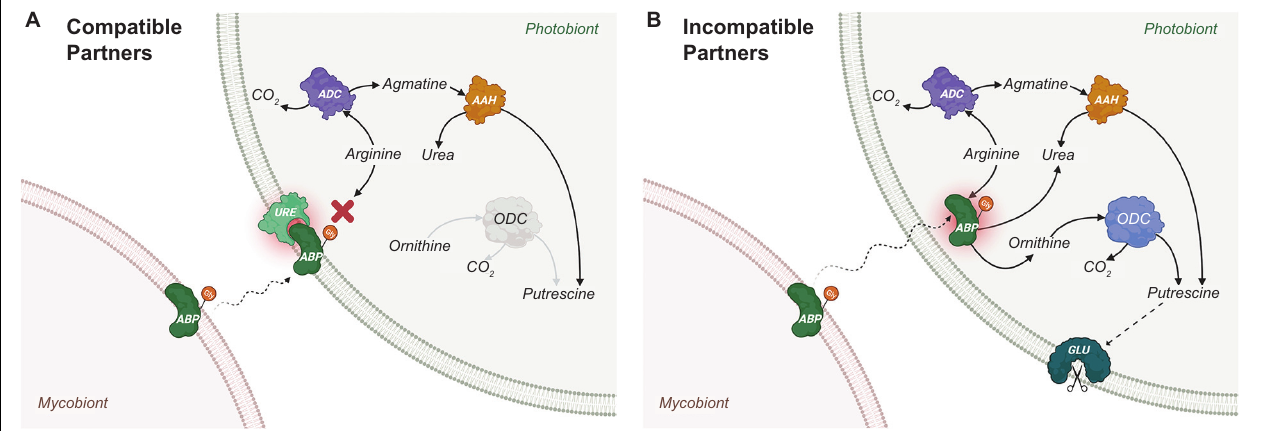
FIGURE 2 | Proposed lectin-ligand recognition and signalling for Xanthoria parietina. (A) For compatible partners. The process starts by the production and positioning of algal binding protein (ABP) on the cell wall of the mycobiont. ABP is a lectin (“receptor”) which is glycosylated and secreted into the intercellular space (Molina et al., 1993; Molina and Vicente, 1995) to bind specific cognate ligands of a photobiont, with which a potential lichenisation could be established. It is speculated that ABP is part of a group of “recognition lectins” that is responsible for engaging the mycobiont with a specific photobiont, and another group of “recruitment lectins” that play a role in recruiting the photobiont cells to mycobiont hyphae (Sacristán et al., 2007). In the lichen X. parietina , a recruitment lectin was identified as a secreted arginase of the Xanthoria mycobiont (SAX). Although both ABP (recognition) and SAX (recruitment) mycobiont lectins were shown to bind to the ligand URE, a glycosylated urease located on the compatible photobiont cell wall (Millanes et al., 2004), it is not clear whether both must attach to urease for lichenisation to proceed. Both ABP and SAX lectins possess identical peptide sequences and Mn 2 + -dependent arginase activity, hydrolysing arginine to produce urea and ornithine (Legaz et al., 2004). However, the glycosidic moiety of SAX contains galactose and glucose, whereas that of ABP contains glucose and N-acetyl-glucosamine (Molina et al., 1993). Upon binding, enzymatic activities of ABP (recognition lectin and receptor) and URE (ligand) are inhibited. As a result, putrescine concentrations in a compatible photobiont are kept at relatively low endogenous levels because it is only produced through arginine decarboxylase (ADC) and agmatine amidinohydrolase (AAH). (B) For incompatible partners. The binding selectivity of ABP (receptor on mycobiont) for URE (ligand on photobiont) is the key in compatible partner recognition. For example, the ABP lectin receptor of E. prunastri can only bind to a single galactosylated ligand (Diaz et al., 2016c). Thus, an incompatible photobiont lacking galactosylated URE would not be recognised, resulting in an internalisation of ABP by the photobiont. Without URE ligand-induced inhibition, ABP goes on to hydrolyse cytoplasmic arginine stores in the photobiont (ABP has a higher affinity for arginine than that of ADC), producing urea and ornithine and a reaction cascade (involving both ornithine decarboxylase (ODC) and AAH) that results in increased cytoplasmic putrescine levels. High intracellular putrescine concentrations lead to the activation of glucanase (GLU), which results in cell wall disruptions and, ultimately, death of the incompatible photobiont cells (Molina et al., 1998). (Image created with